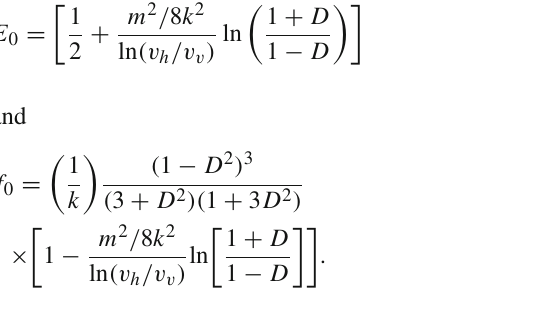
SolidCurve : withstabilizing field DashedCurve : withoutstabilizing filed